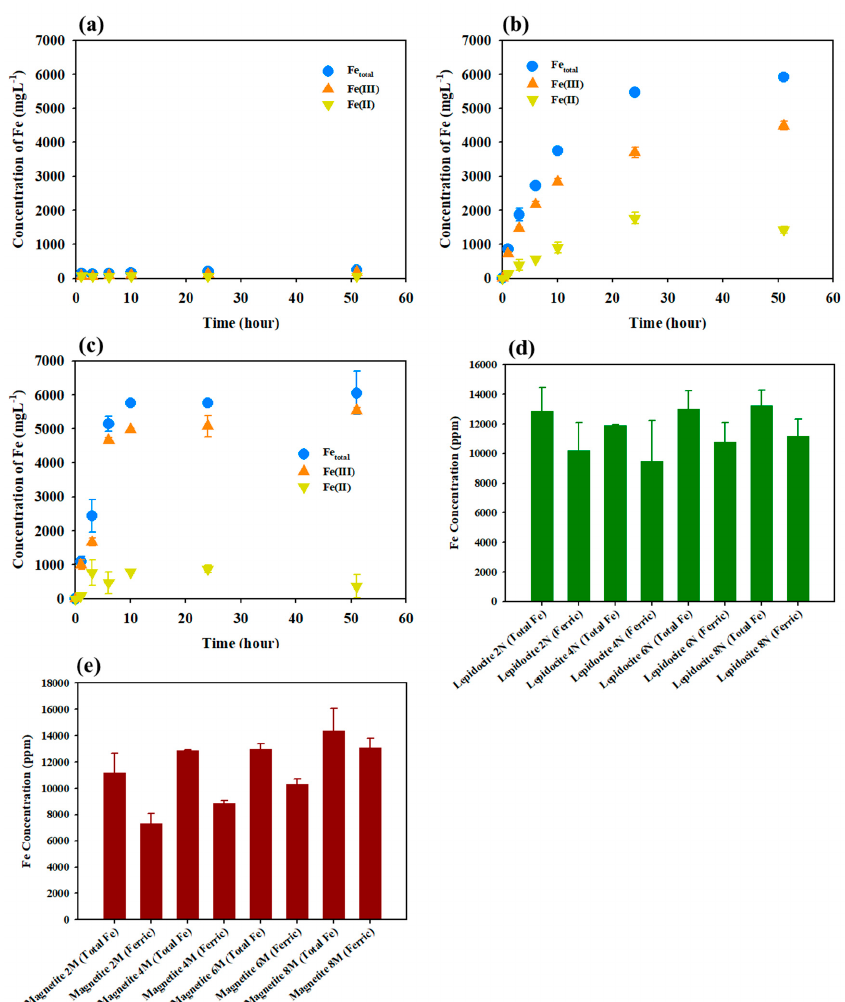
Figure 2. Kinetics of Fe dissolution in suspensions of Fe(III)-containing minerals (2 N HCl); ( a ) hematite, ( b ) magnetite, ( c ) lepidocrocite, ( d ) dissolved Fe amount for lepidocrocite, and ( e ) magnetite in different HCl concentrations. Experimental conditions: ( a – c ) [minerals] 0 = 10 g · L − 1 , ( d , e ) [minerals] 0 = 20 g · L − 1